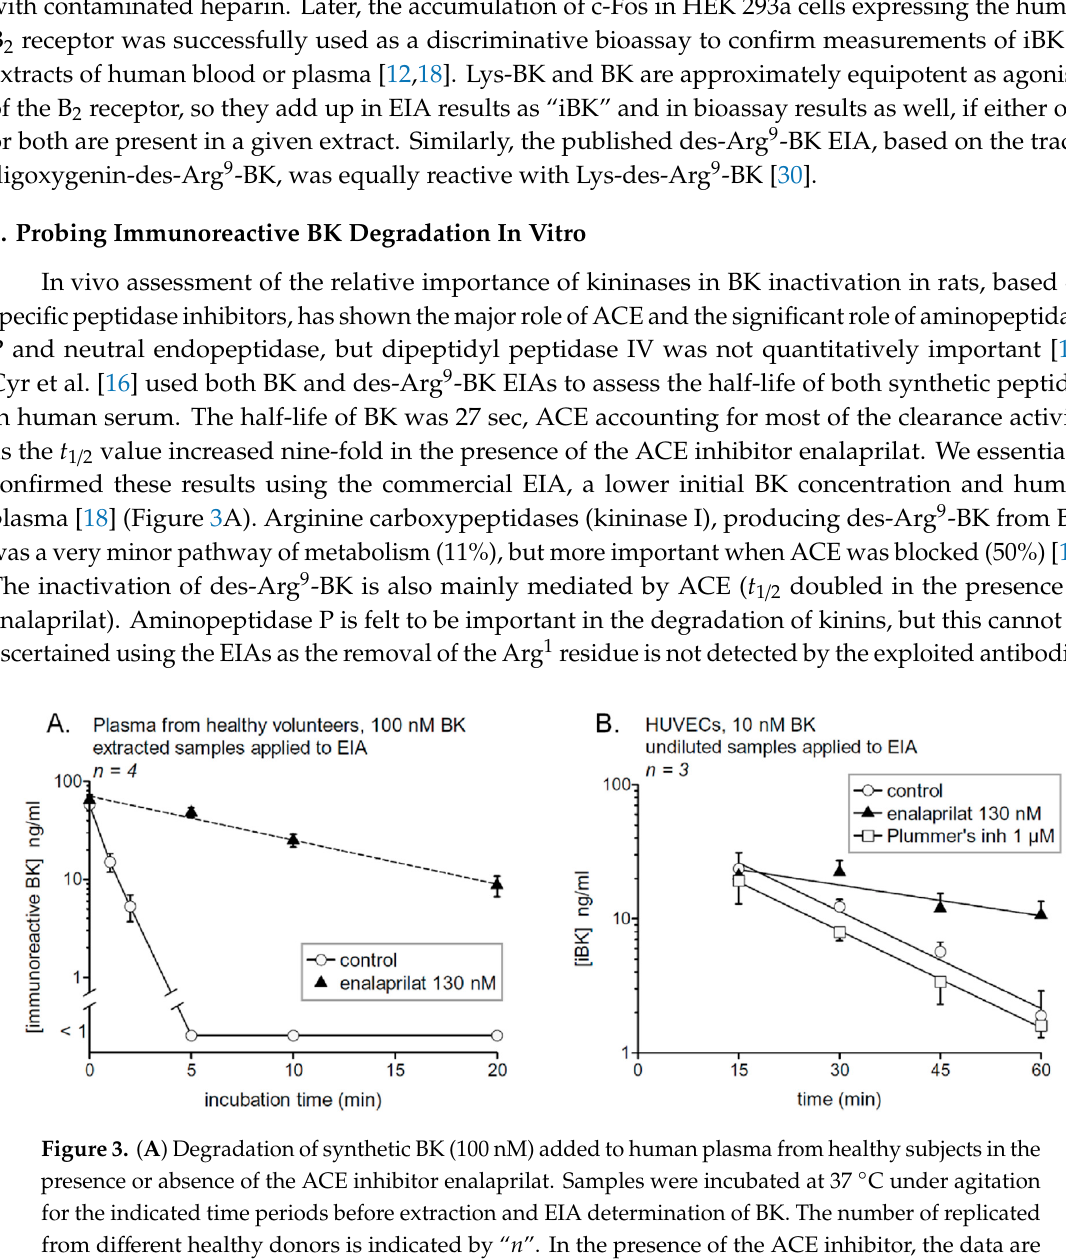
Figure 4. Effect of incubation under agitation in Hank’s balanced salt solution containing BK (500 nM) on adherent HUVECs (matched phase contrast and red fluorescence fields, original magnification 100×). Propidium iodide (PI) staining was performed as a test of viability (positive control, Triton X100, 0.5%). Total counted cell numbers are given next to the histograms.